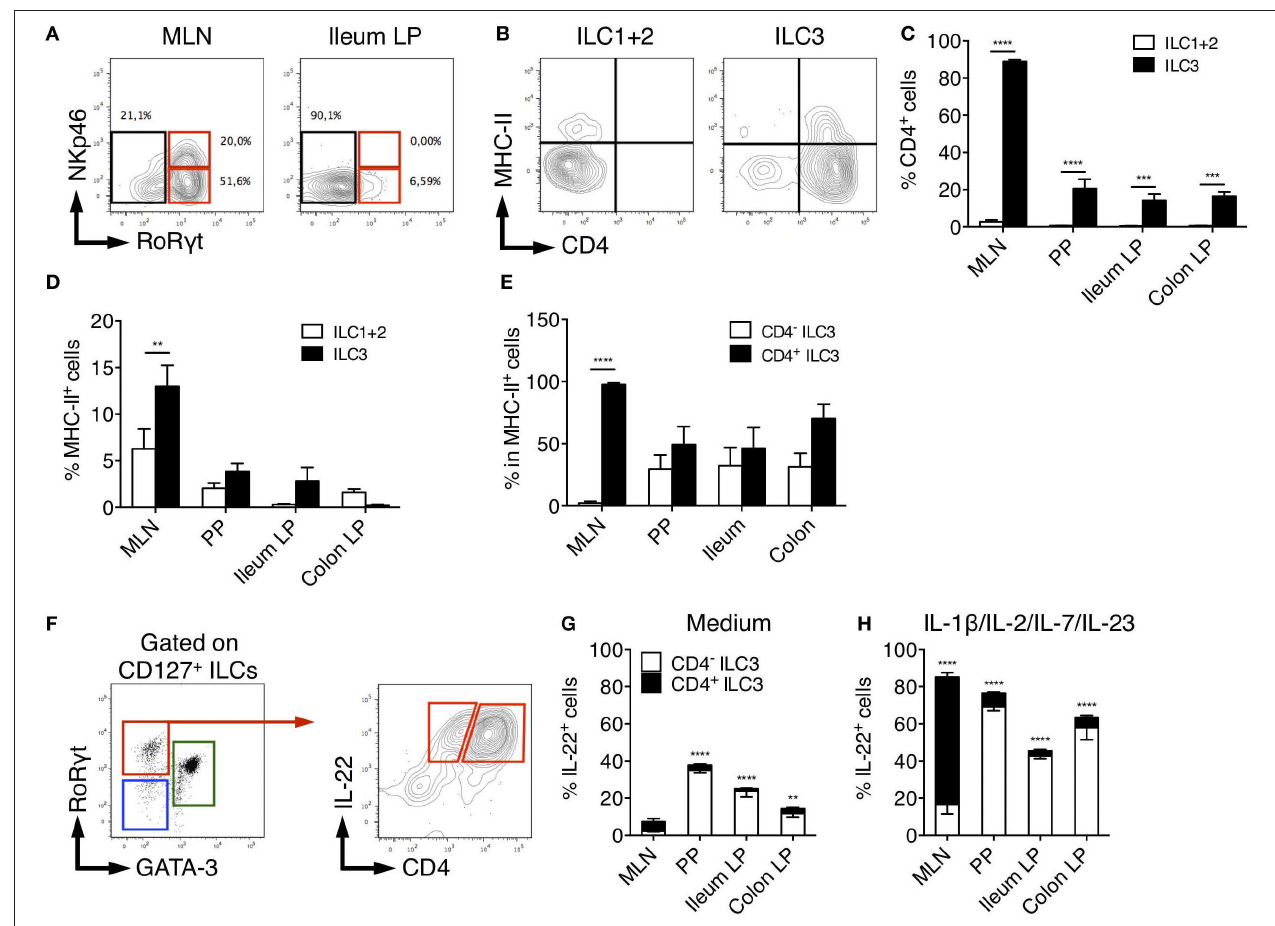
FIGURE 4 | Characterization of rat ILC3 subsets. (A) Representative flow cytometry plots showing NKp46 and ROR γ t expression among total ILC cells isolated from the MLN and ileum LP of SPD rat (B) Representative flow cytometry plots showing CD4 and MHC-II expression by ILC1/2 and ILC3 cells isolated from the MLN of SPD rat. (C) The percentage of CD4 + and (D) MHC-II + cells among ILC1/2 (white bars) or ILC3 (black bars) isolated from the indicated tissues of SPD rat. (E) The percentage of MHC-II + cells amongst CD4 − (white bars) and CD4 + (black bars) ILC3 cells. (F) Representative flow cytometry plots showing the gating strategy to identify CD4 − and CD4 + IL-22-producing cells among ILC3 isolated from the colon LP of SPD rat. (G) Frequencies of the CD4 + and CD4 − cells amongst IL-22 producing ILC3 after 4h of culture in the absence (G) or the presence of the indicated stimulating cytokines (H) . n = 6 per each tissue. ** p < 0.01, *** p < 0.001, **** p <